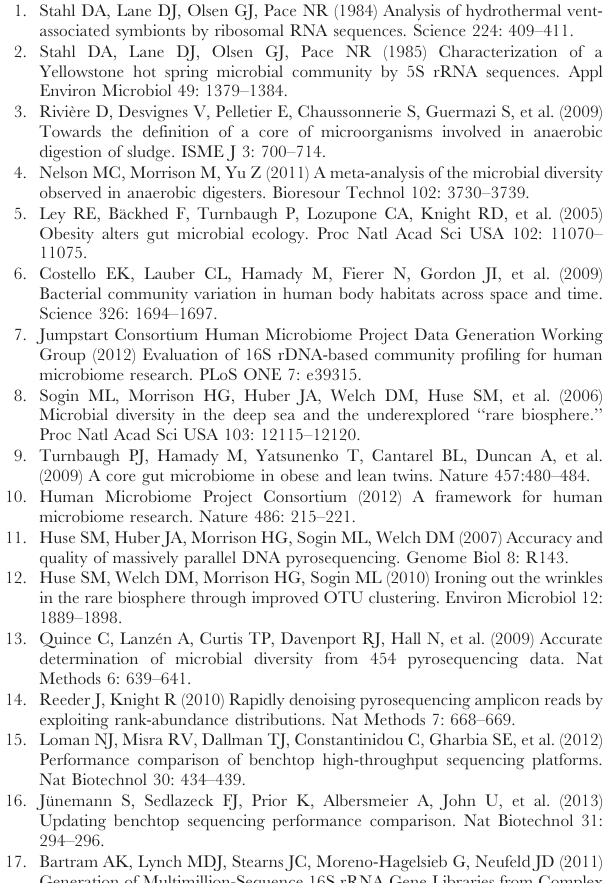
Figure S2 Effect of processing method and Greengenes reference on taxonomic composition of the human stool sample. Table S1 Comparison of the number of OTUs and retained reads using different processing methods. Table S2 Comparison of OTU filtering cut-off